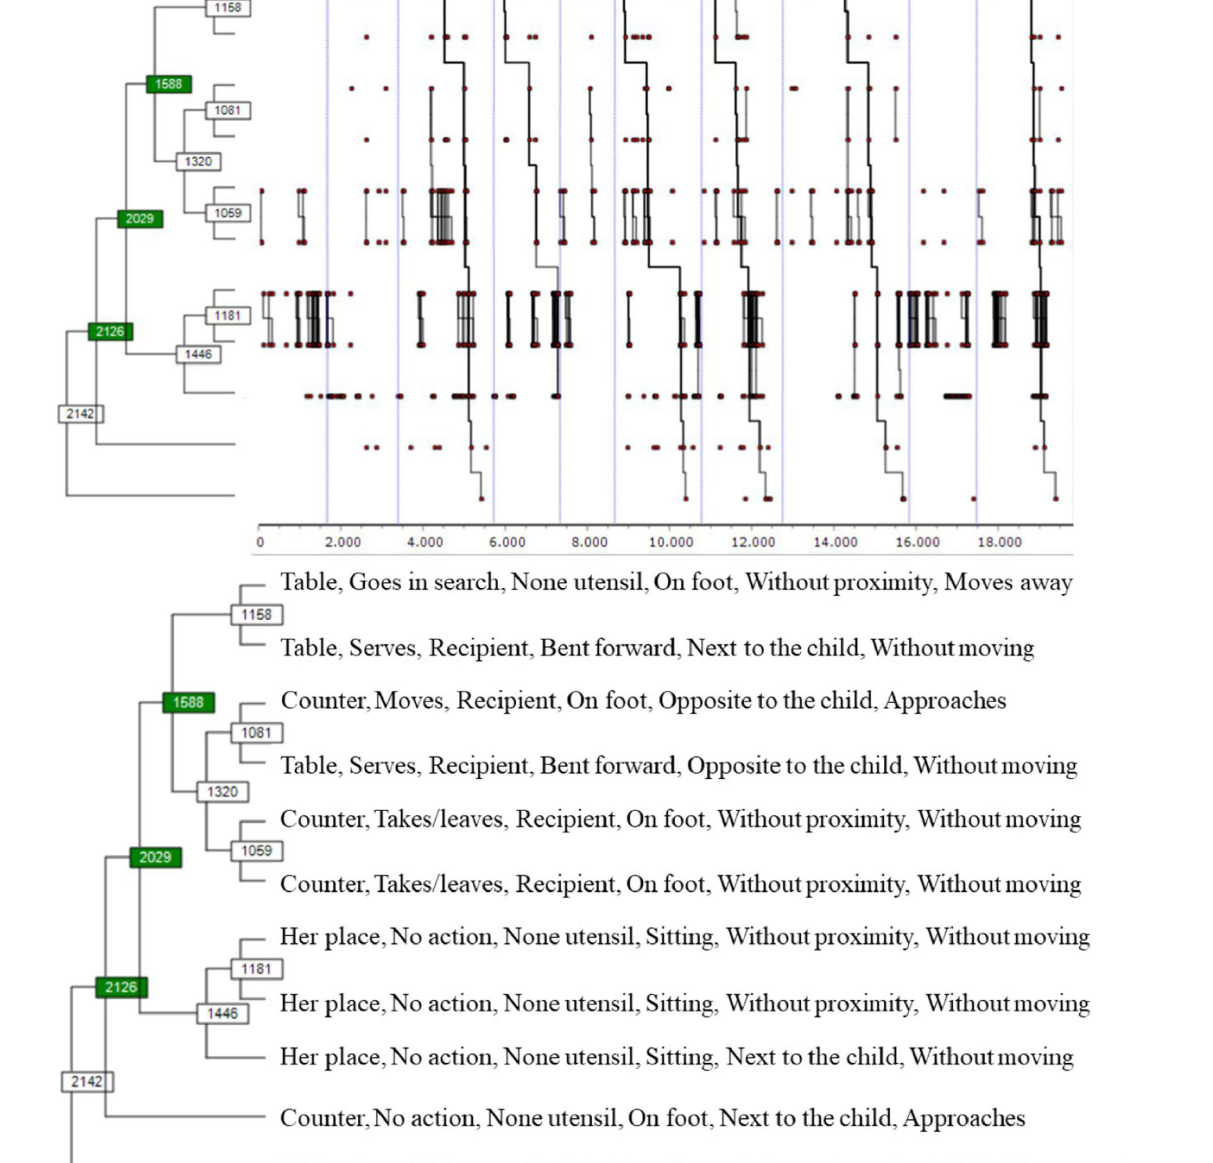
FIGURE 2 T-pattern of Educator-1 ʼ s behavior obtained with GBEPNS-IPv2.